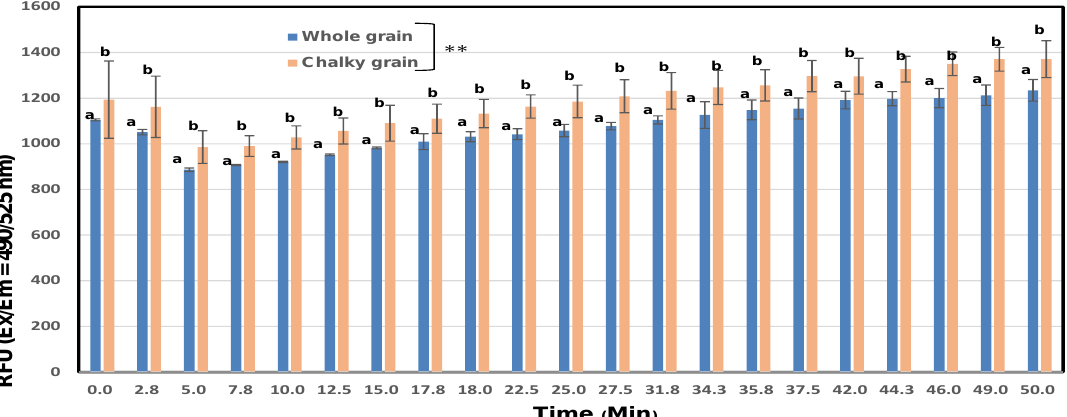
Figure 10. Proteinase activities of unpolished rice flours prepared from whole or chalky unpolished rice grains premium rice Koshihikari. Different letters (a, b) mean that whole and chalky grains in each same rice samples are significantly different. ** Correlation is significant at 1% by the method of Tukey’s multiple comparison.